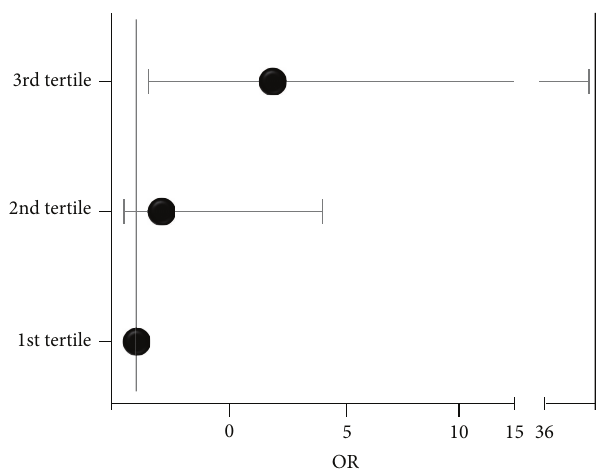
Figure 2: Risk of endothelial dysfunction in the three tertiles. Odds ratio (OR) = 6.9 (95% C.I. 1.4–35.1, 𝑝 = 0.0069 ) comparing patients of the 3rd tertile with those of the 1st tertile.